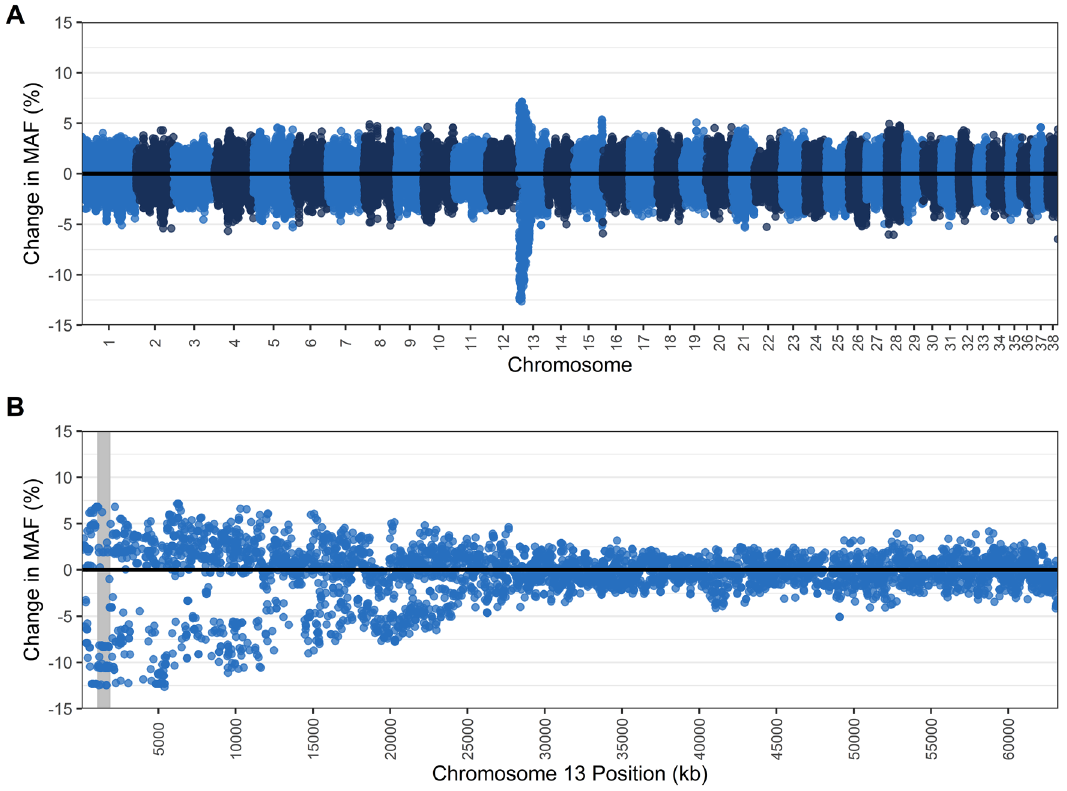
Figure 3. Change in the minor allele frequency (MAF) ( A ) across all autosomes and ( B ) within chromosome 13, where the VPS13B gene is located (position shaded in grey), when TNS carriers (N = 47) and affected (N = 2) dogs are removed from the population, leaving dogs clear of the TNS mutation (N = 157). Each dot represents a single nucleotide polymorphism